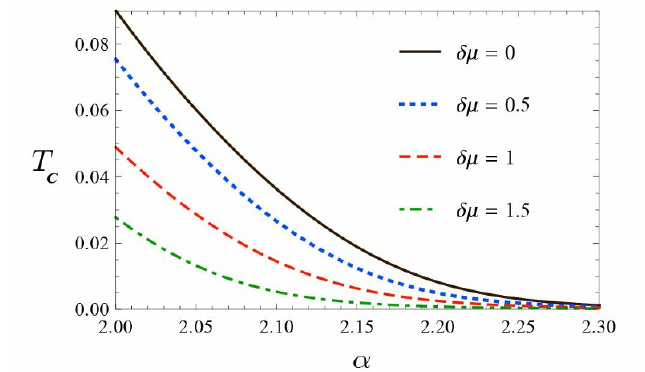
Figure 2. Diagram of critical temperature T c as a function (cid:11) for the chosen function F ( ) = (cid:11) . From up to down we have (cid:14)(cid:22) = 0 ; 0 : 5 ; 1 ; 1 :